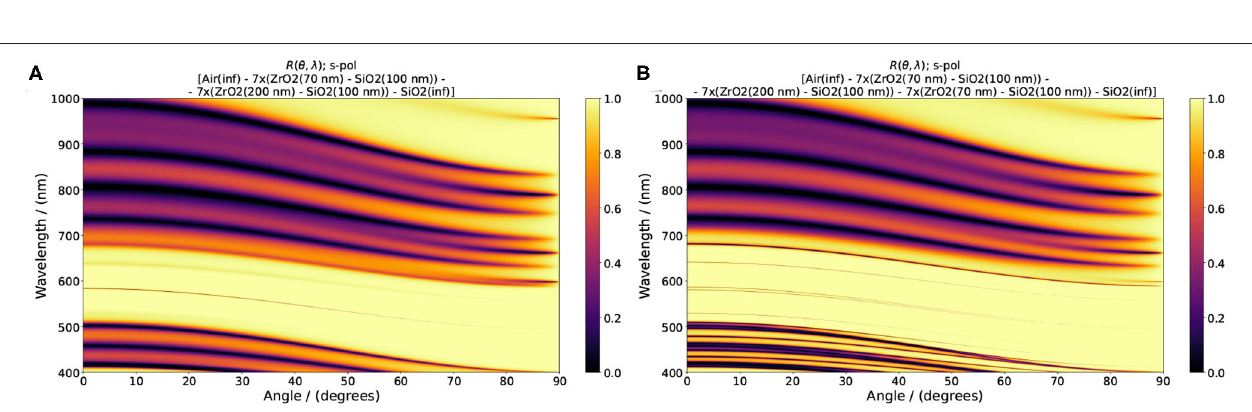
FIGURE 11 | Reflectance of stacks of two (A) and three (B) photonic crystals producing optical Tamm states in the bandgap, as function of the angle of incidence. The incidence of s-polarized light is from air and the substrate of the stack is silica. The optical Tamm states correspond to full transmission lines in the forbidden band, indicated by the narrow dark curves in the center of the bandgap. In (A) there is only one line. In (B) , the interaction between symmetric edge states produces 4 lines.